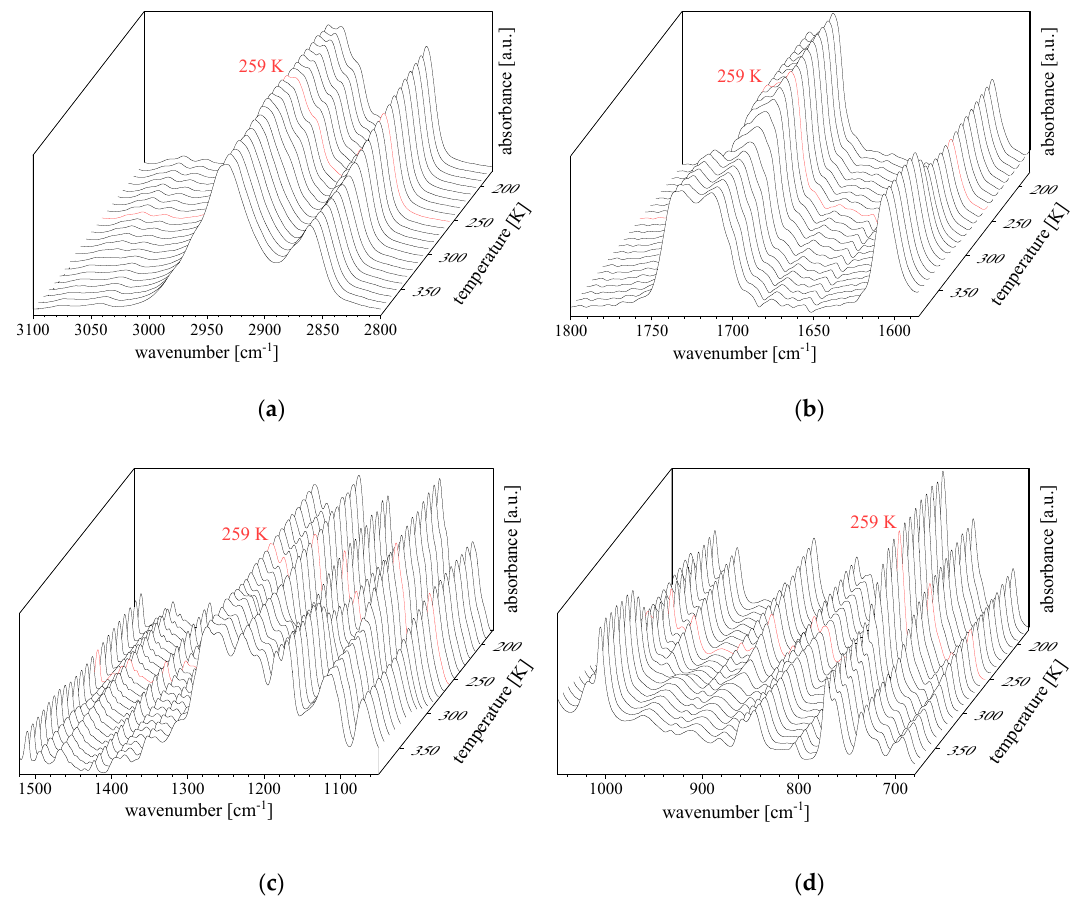
Figure 4. The FTIR spectra of 3F7HPhH7 upon cooling at a rate of 2 K/min from 403 to 173 K in the wavenumber regions of: ( a ) 3100–2800 cm –1 , ( b ) 1800–1580 cm –1 , ( c ) 1520–1050 cm –1 and ( d ) 1050–680 cm –1 .